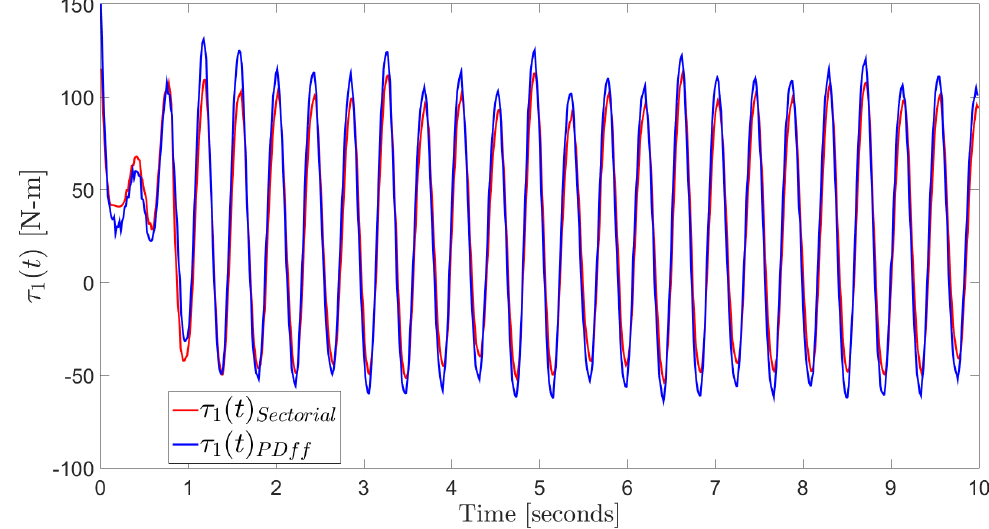
Figure 27. Applied torque to joint 1.